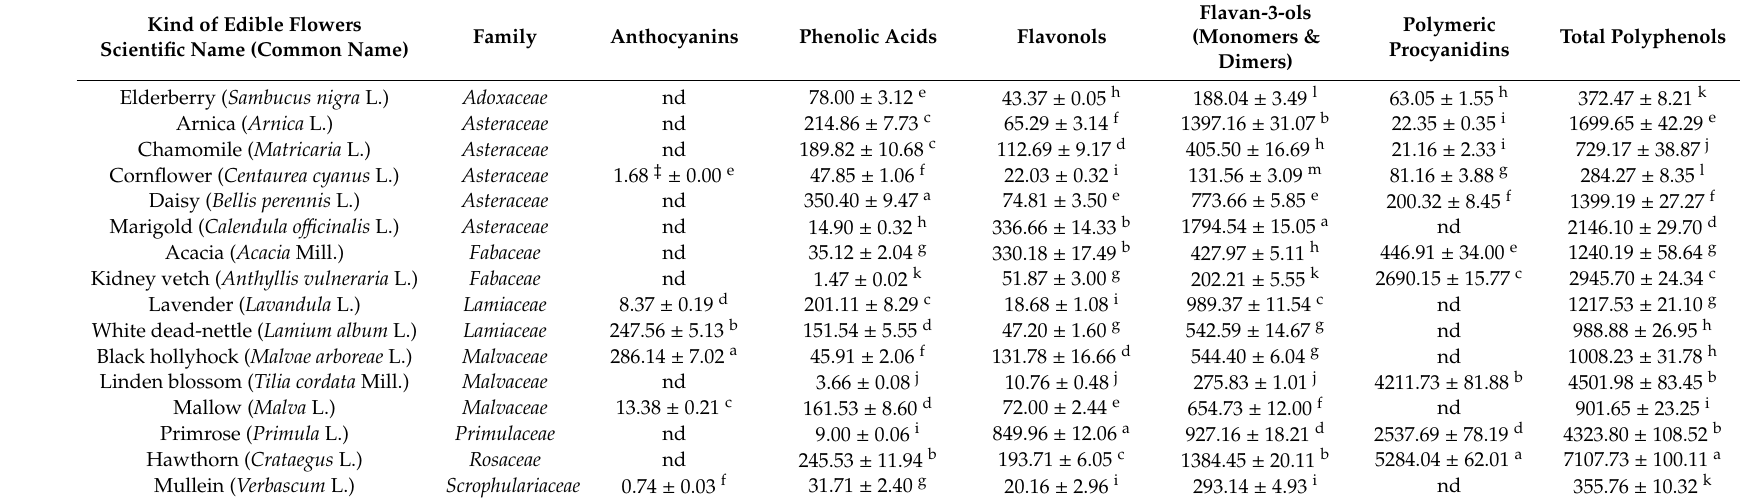
Table 1. Content of phenolic compounds (mg / 100 g dm) in 16 selected edible